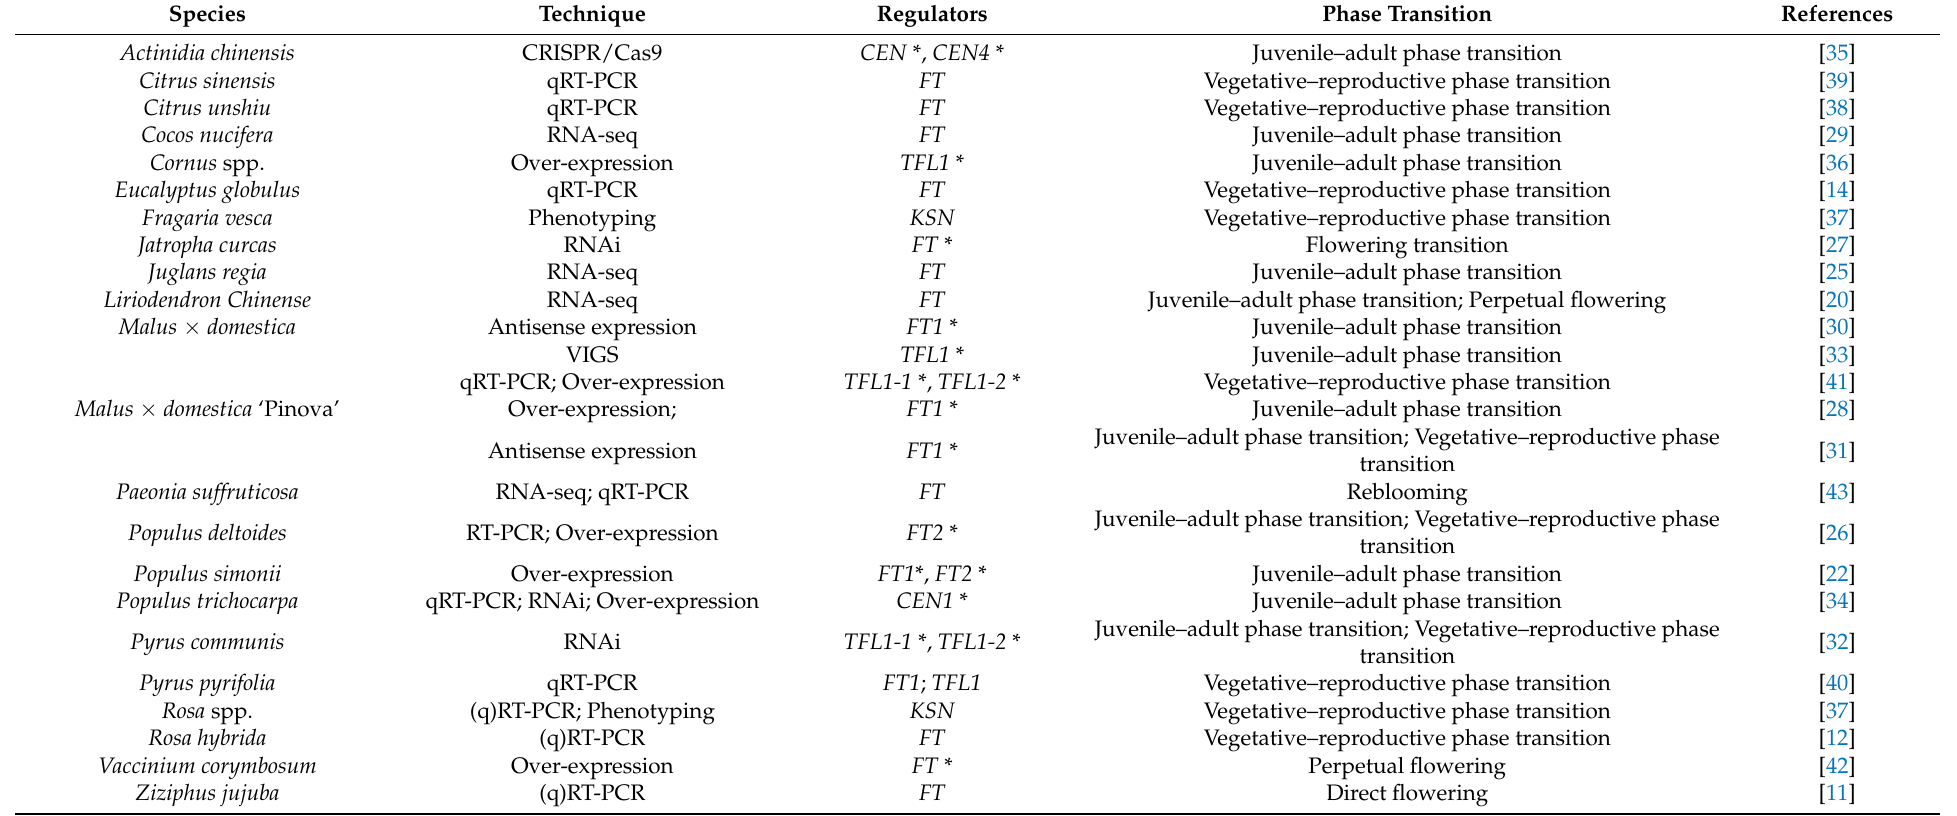
Table 2. Summary of PEPB gene family mediated flowering regulation in woody